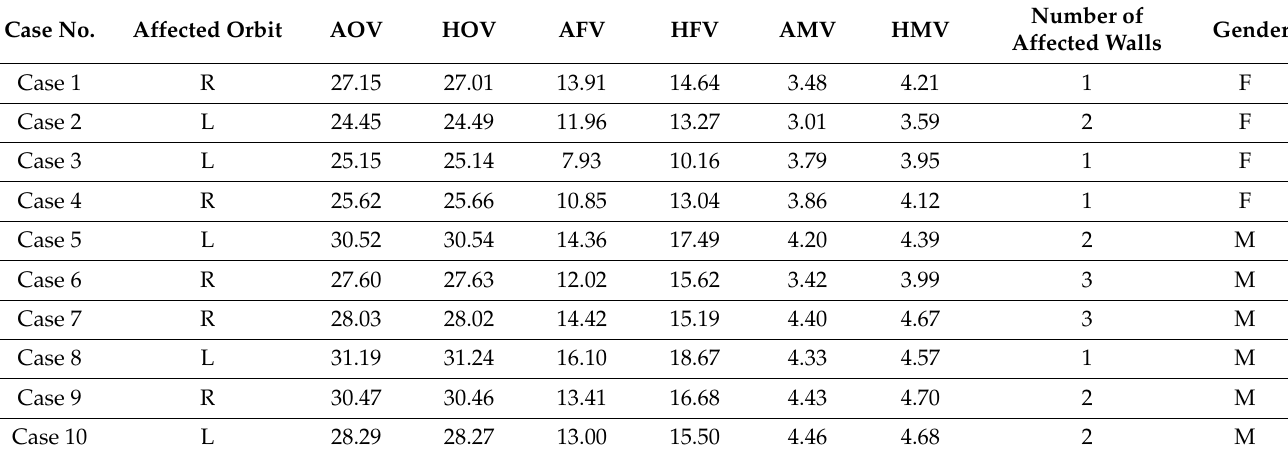
Table 1. Systematization of the main results.